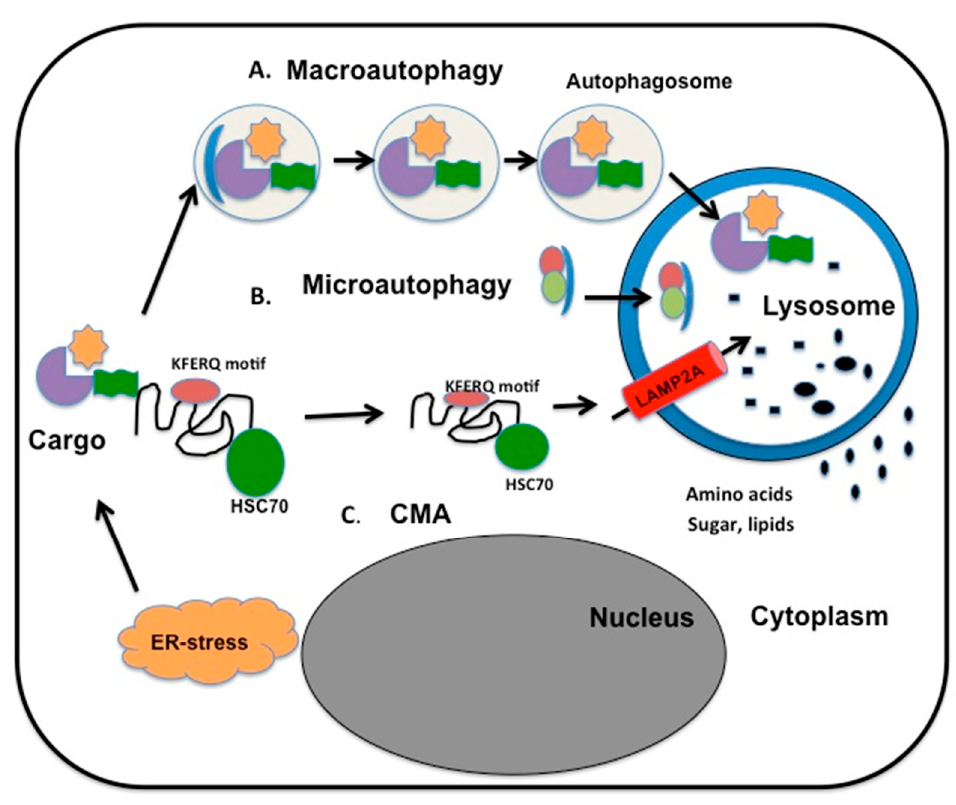
Figure 4. Schematic illustrations of different types of autophagy. ( A ) During macroautophagy, the cargo targeted for destruction is enclosed in double ‐ membrane vesicles called autophagosomes that deliver the contents to the interior of lysosome through membrane fusion. The metabolites (amino acids, sugars and lipids) are then released into the cytoplasm for the synthesis of new macromolecules or as a source of energy. ( B ) In microautophagy, the cargo directly enters the lysosome by membrane invagination and degradation. ( C ) During chaperone ‐ mediated autophagy (CMA), proteins with pentapeptide KFERQ ‐ like sequences are recognized by the heat shock cognate protein complex 70 (HSC70) chaperone. This complex then binds to LAMP2A on the lysosome membrane for subsequent internalization and degradation.